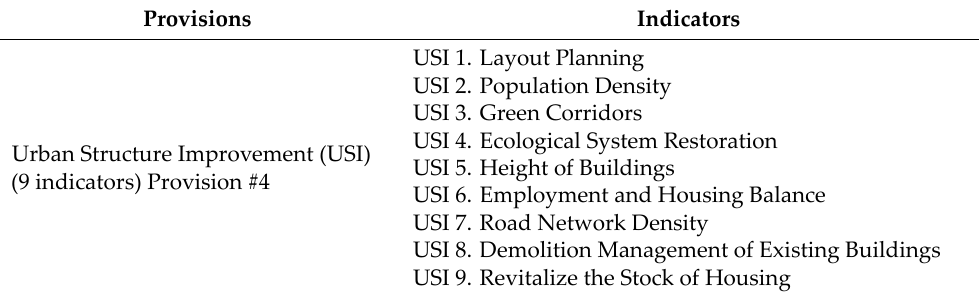
Table 3. Included provisions and indicators (the specifications as interpreted by the authors are shown in Appendix